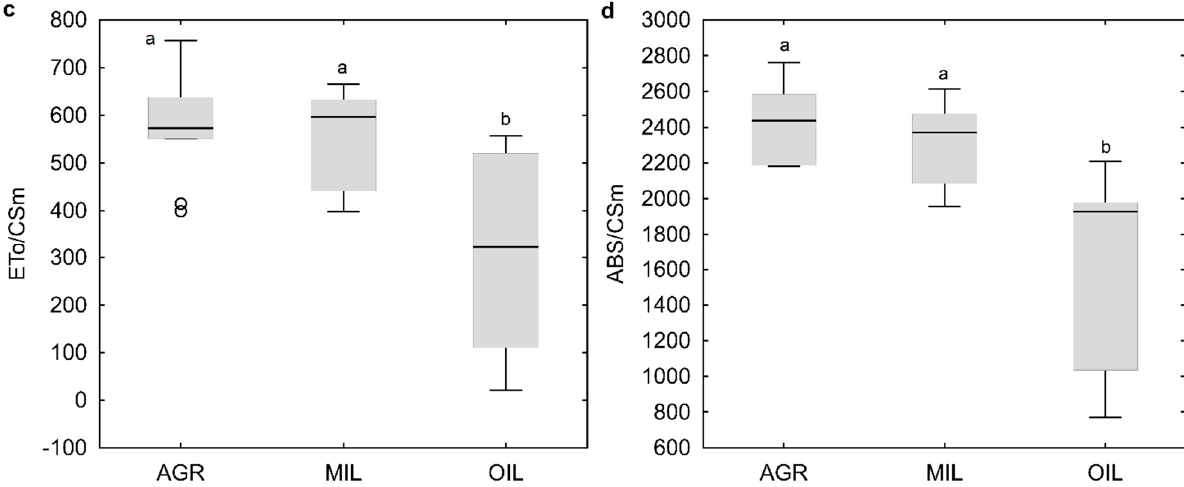
Figure 3. Physiological indicators Fv/Fm ( a ), TR 0 /CS 0 ( b ), ET 0 /CSm ( c ) and ABS/CSm ( d ) (line: median, box: first-third quartile, whiskers: non-outlier range, circle: outlier); the same letters above boxplots mark comparable groups according to Wilcoxon rank sum test ( p < 0.05)